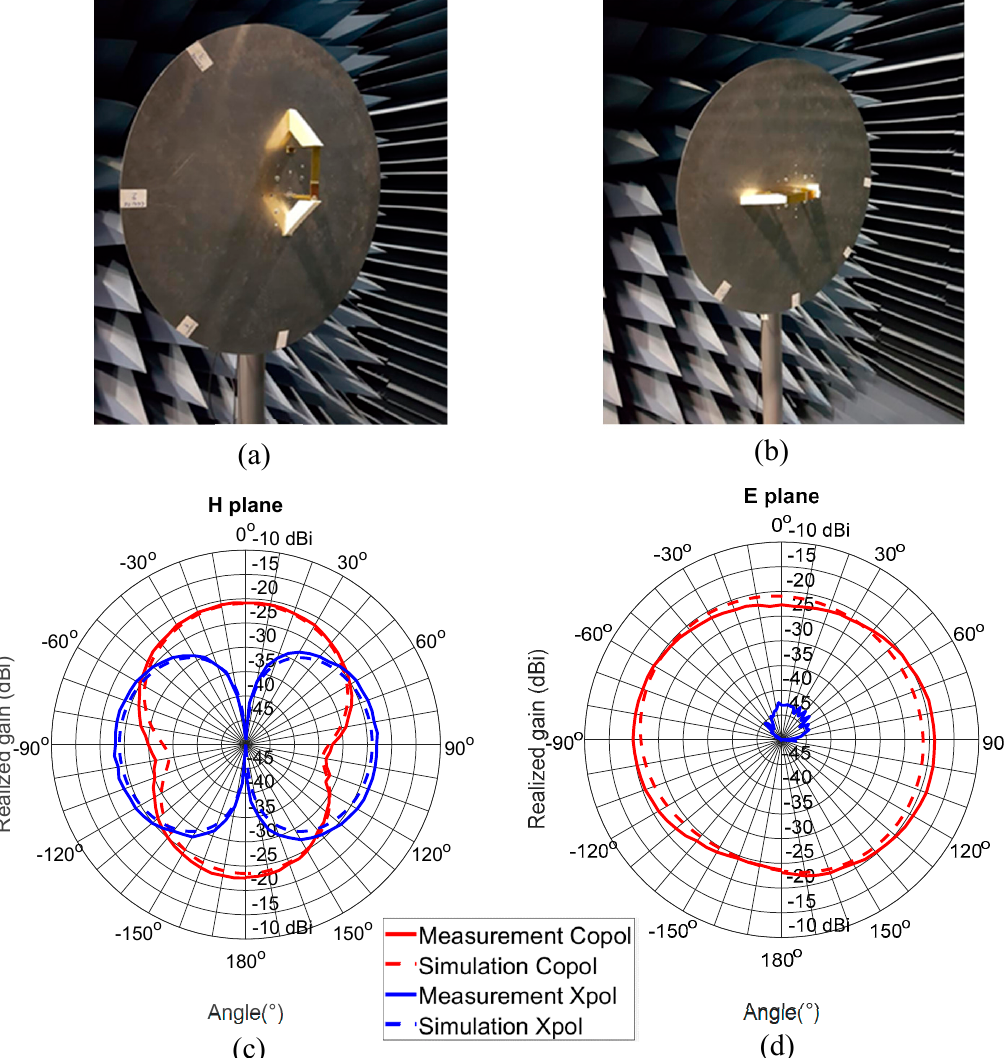
Figure 12. Two cut planes considered for radiation pattern measurement ( a ) H plane illustration, ( b ) E plane illustration, ( c ) antenna gain patterns in the H plane and ( d ) gain patterns in the E plane .